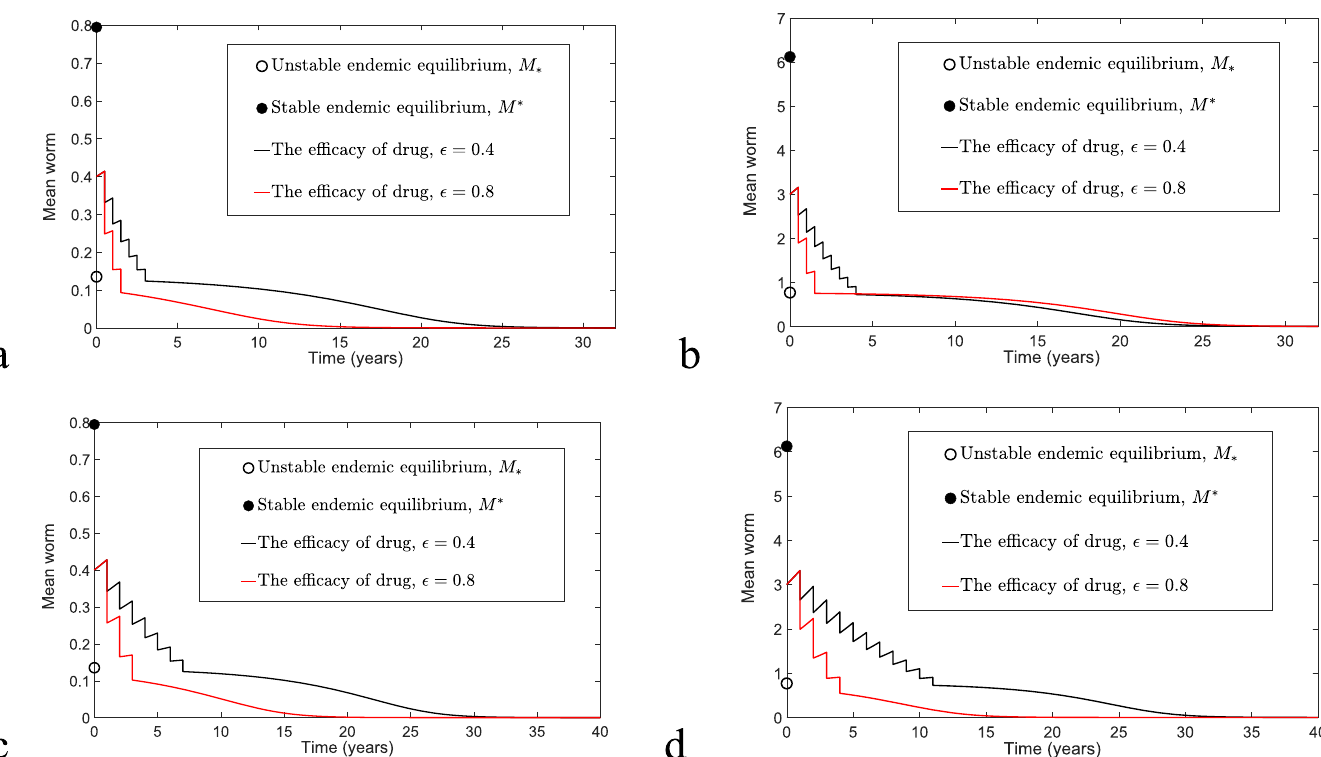
Fig 3. Transmission dynamics of model (3) and (4) by considering the implementation of biannual and annual MDA, M 0 > M � , varying � and choosing z = 0.96, R 0 = 2 and ω = 0.5. Top row: biannual MDA. Bottom row: annual MDA. Left column: k = 0.05. Right column: k =